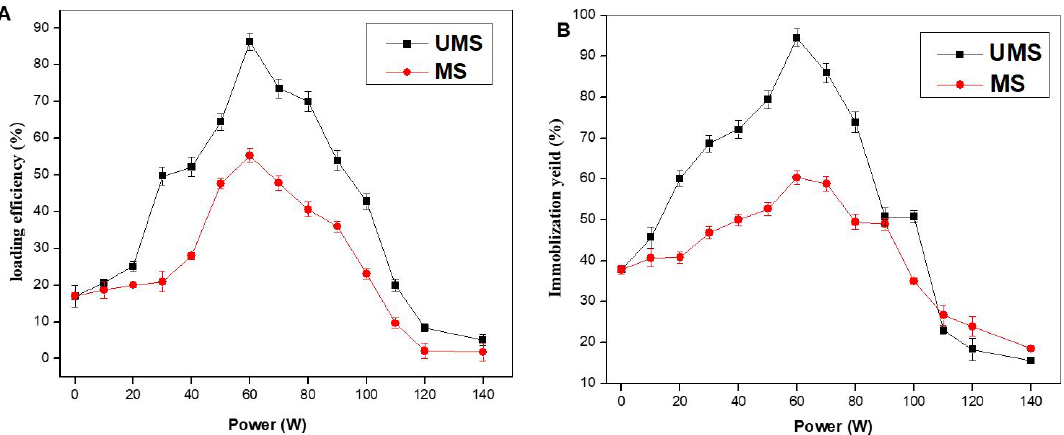
Figure 1. ( A ) LE and ( B ) IY of the immobilized enzyme produced with and without UMS and MS treatments.